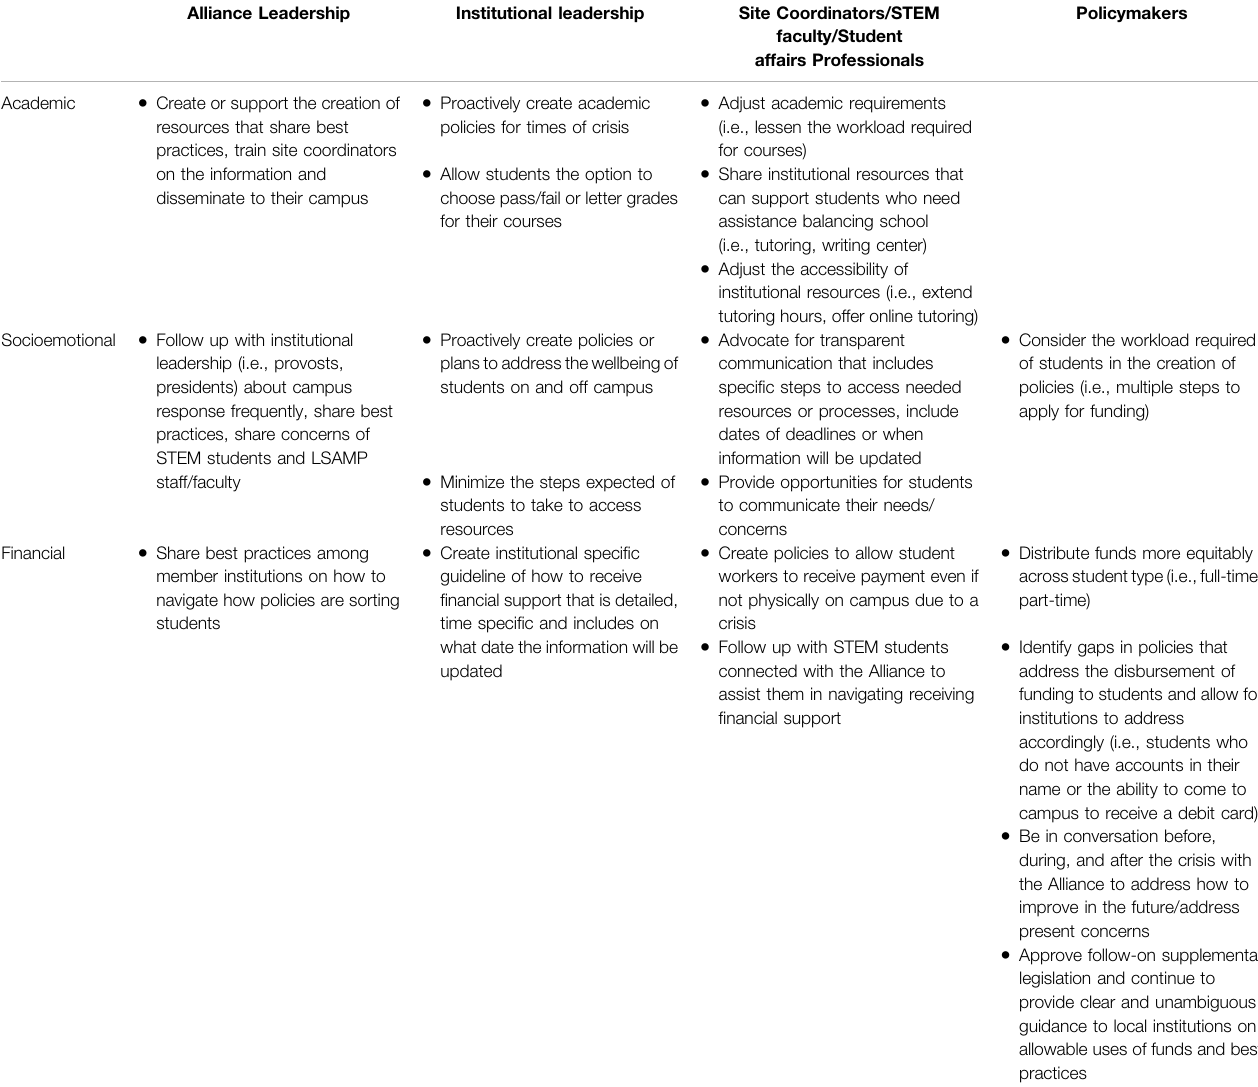
TABLE 3 | Matrix of stakeholder recommendations to support URM STEM student success amid a crisis. Alliance